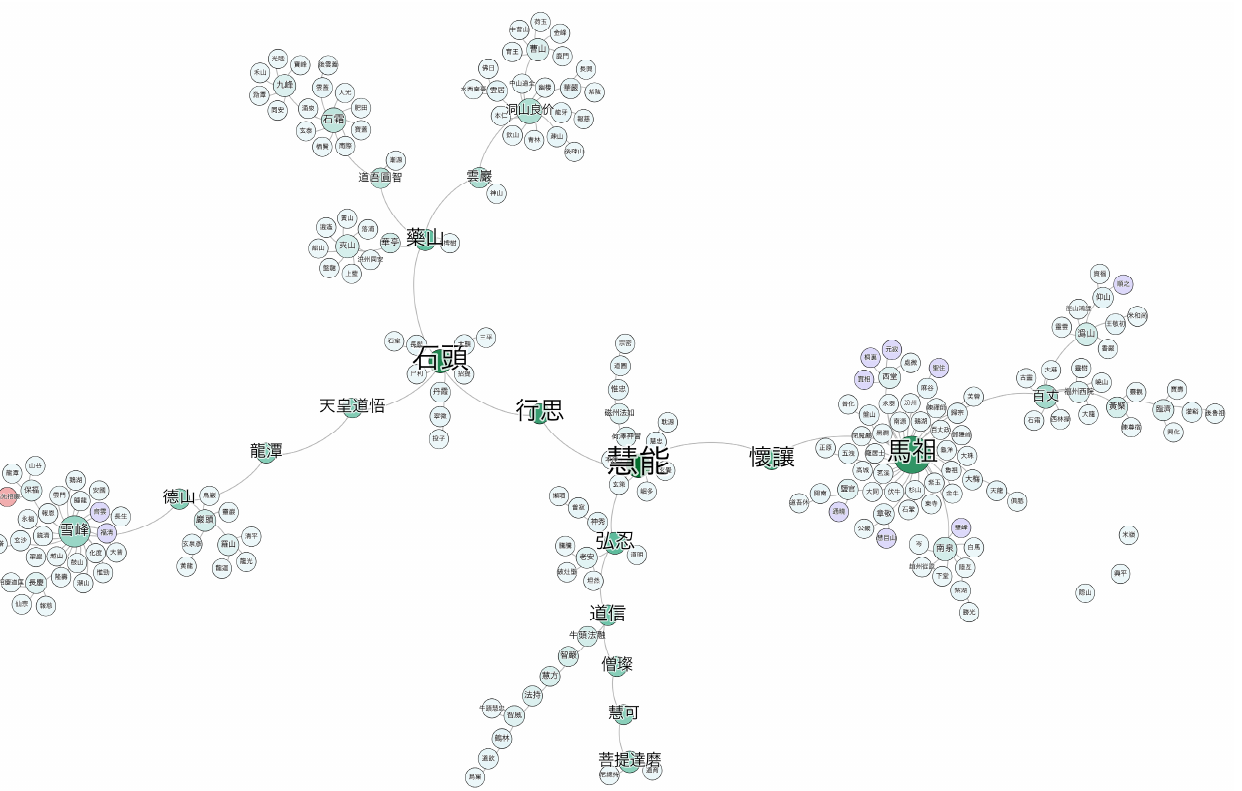
Figure 2. Overview of the ZTJ ’s version of Chan genealogy: from Bodhidharma onwards. Generated with Gephi (version 0.9.5), with Force Atlas 2. Description is identical to Figure 1. The nodes of the Silla monks are colored in purple. Table 1. Figures ranked by degree centrality ( ≥ 5) in the ZTJ ’s genealogical network.